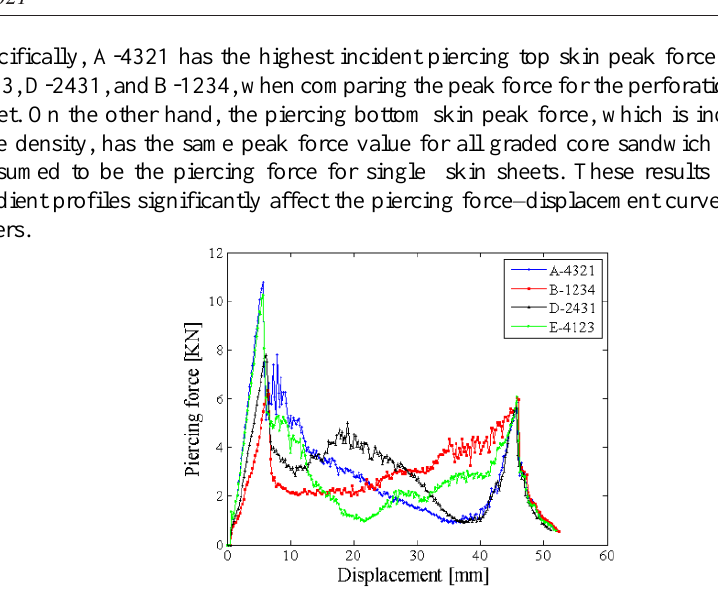
Fig. 3. Plots of simulated piercing force versus displacement (v=45 m/s).